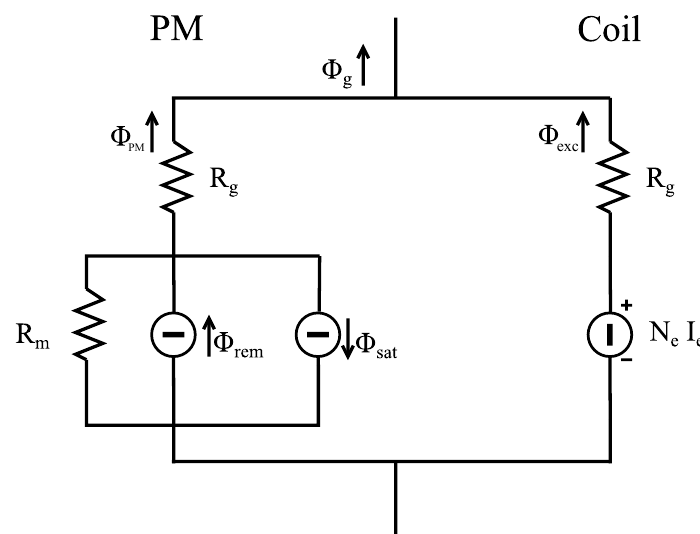
Figure 11. Magnetic equivalent circuit of hybrid excitation.